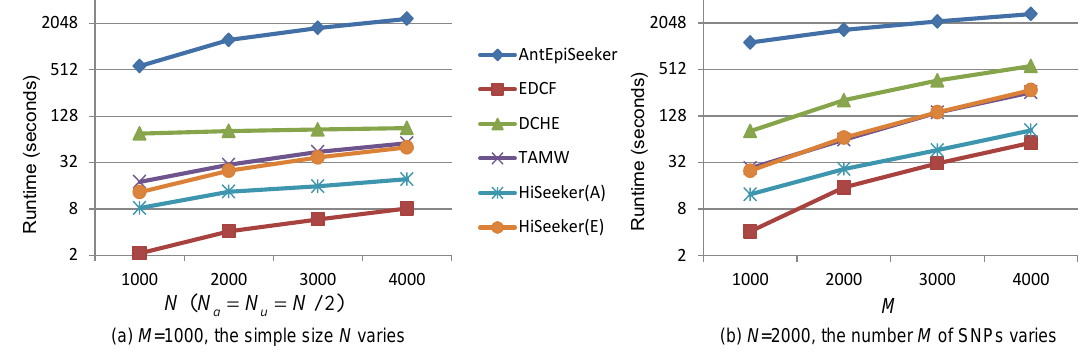
Figure 7. Runtime of different methods on simulated datasets. ( a ) The sample size N varies from 1000 to 4000 while the number of SNPs M = 1000; ( b ) the number of SNPs varies from 1000 to 4000 while N =